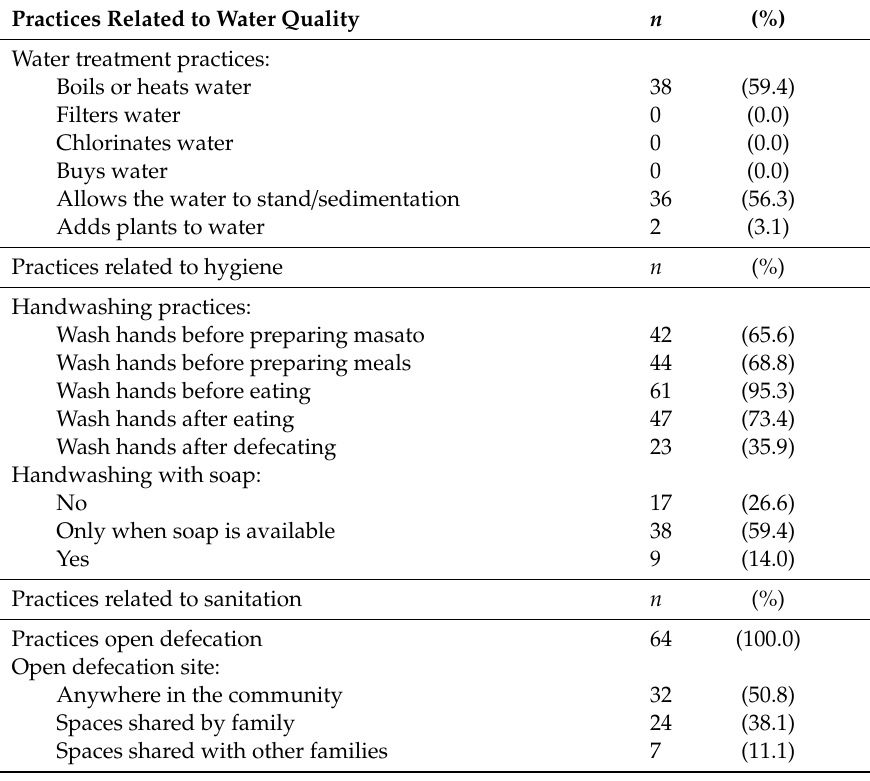
Table 3. The description of practices related to water, hygiene, and sanitation, in the two Shawi communities, Peru ( n =